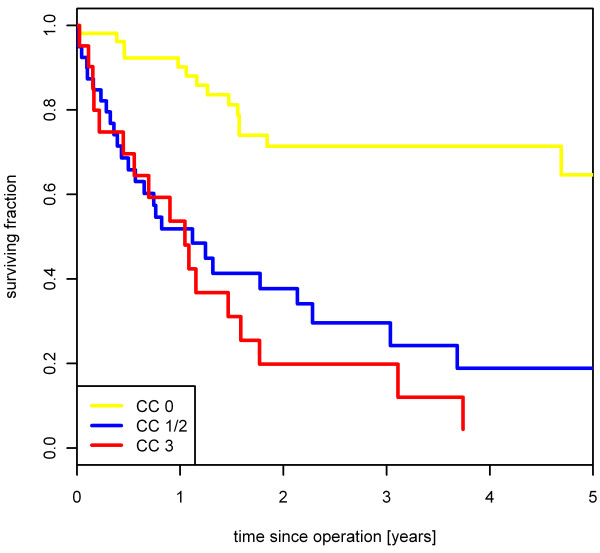
Influence of completeness of cytoreduction on survival. Completeness of cytoreduction correlates significantly with survival (N = 111; P < 0.001).